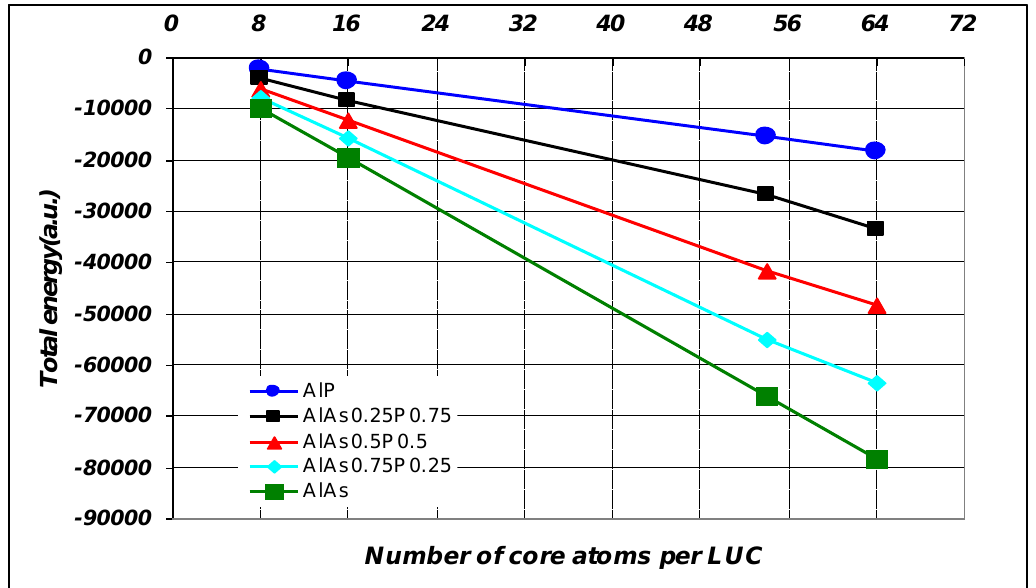
Fig.3: Total energy of Al As atoms per